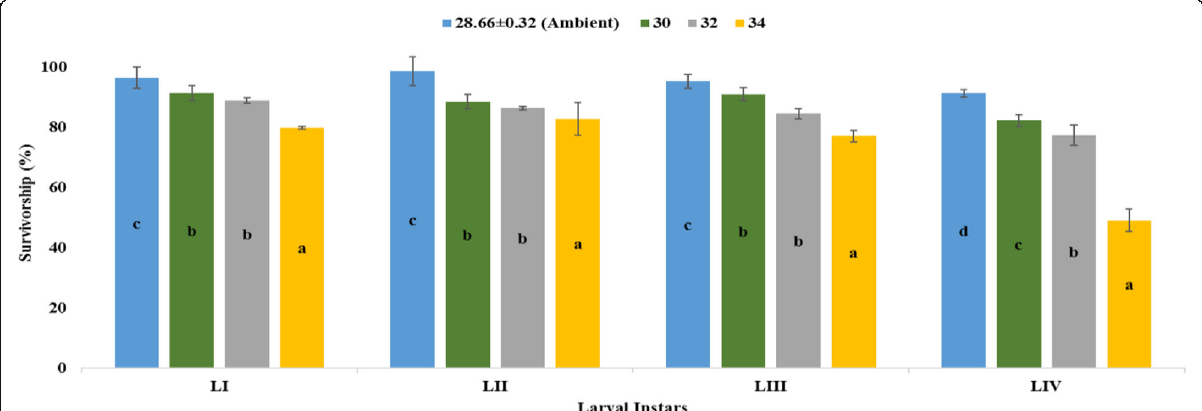
Fig. 2 Effects of rearing-water temperature on survivorship of larval instars (LI – IV) of Culex quinquefasciatus mosquito. Temperature bars with same letter at each larval instar are not significantly different at p < 0.05 according to analysis of variance. Values are expressed as mean ± SD